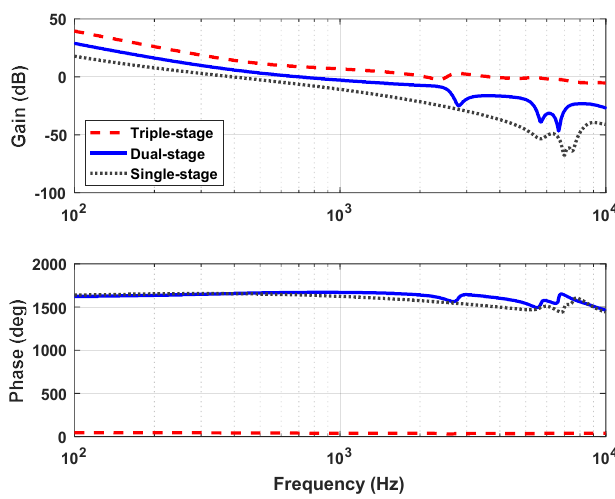
Figure 16. Error signal.